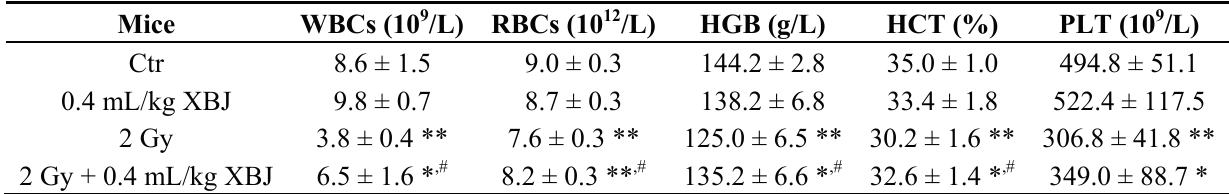
Table 2. Peripheral blood cells were counted nine days after 2 Gy TBI. WBC, white blood cell; RBC, red blood cell; HGB, hemoglobin; HCT, red blood cell specific volume; PLT,